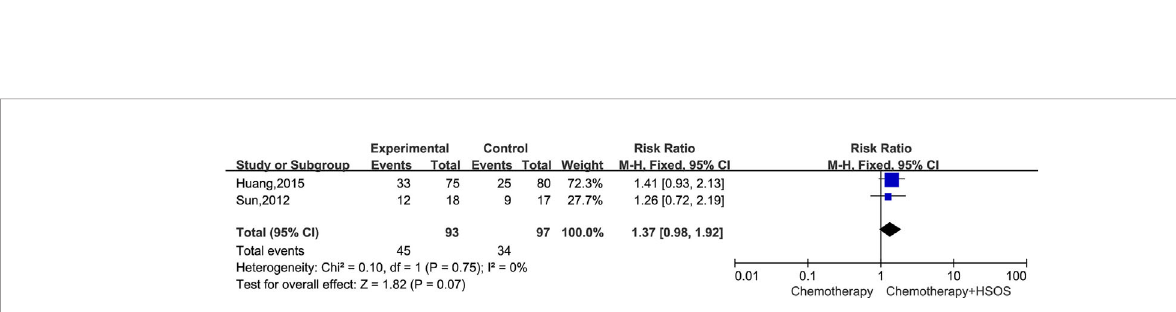
FIGURE 6 | Forest plot of 1-year survival rate with chemotherapy combined with HSOS versus chemotherapy alone.